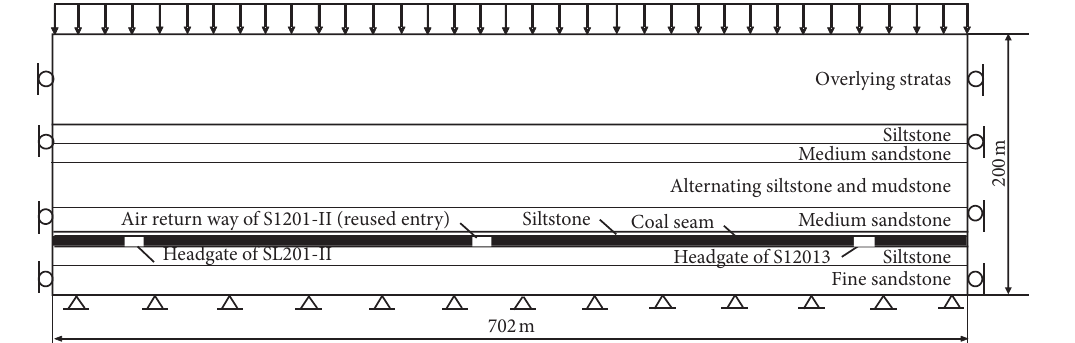
Figure 5: Numerical calculation model. Table 1: Physicomechanical parameters of rock